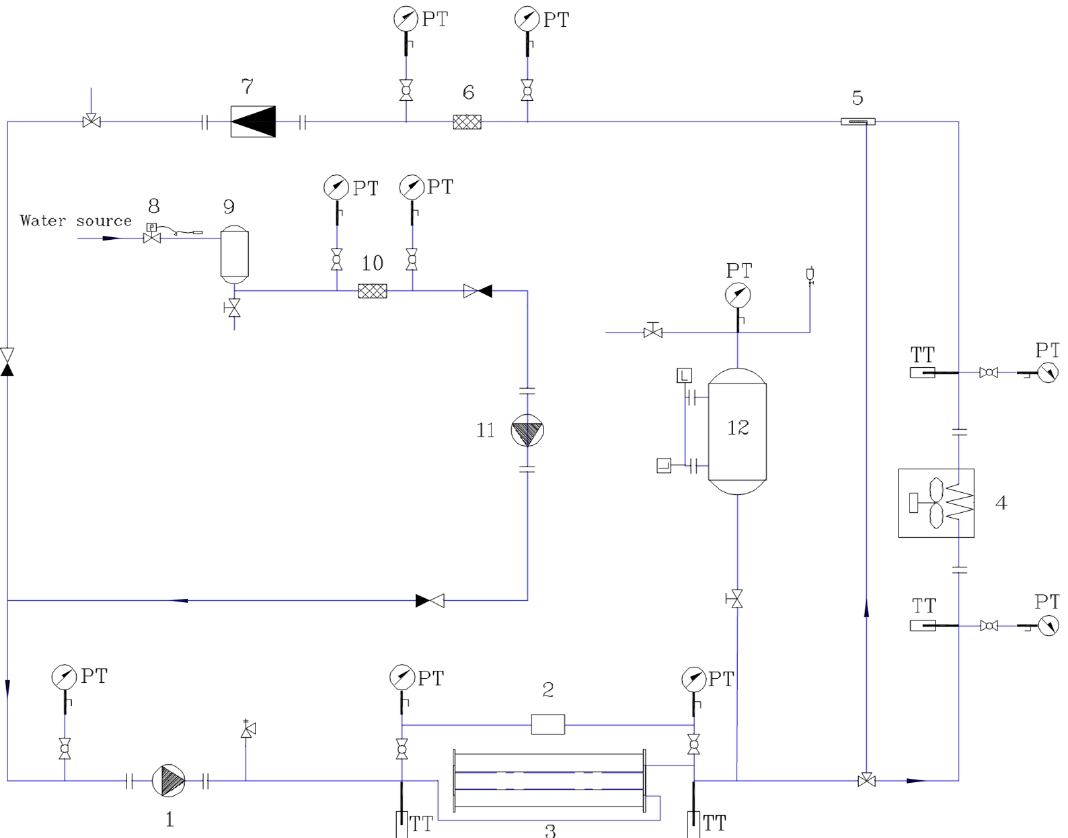
Figure 2. Schematic diagram of the experimental system with demineralized water treatment. 1: